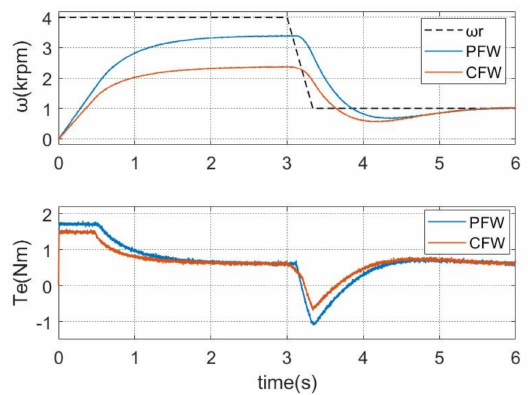
Figure 14. Speed and torque.